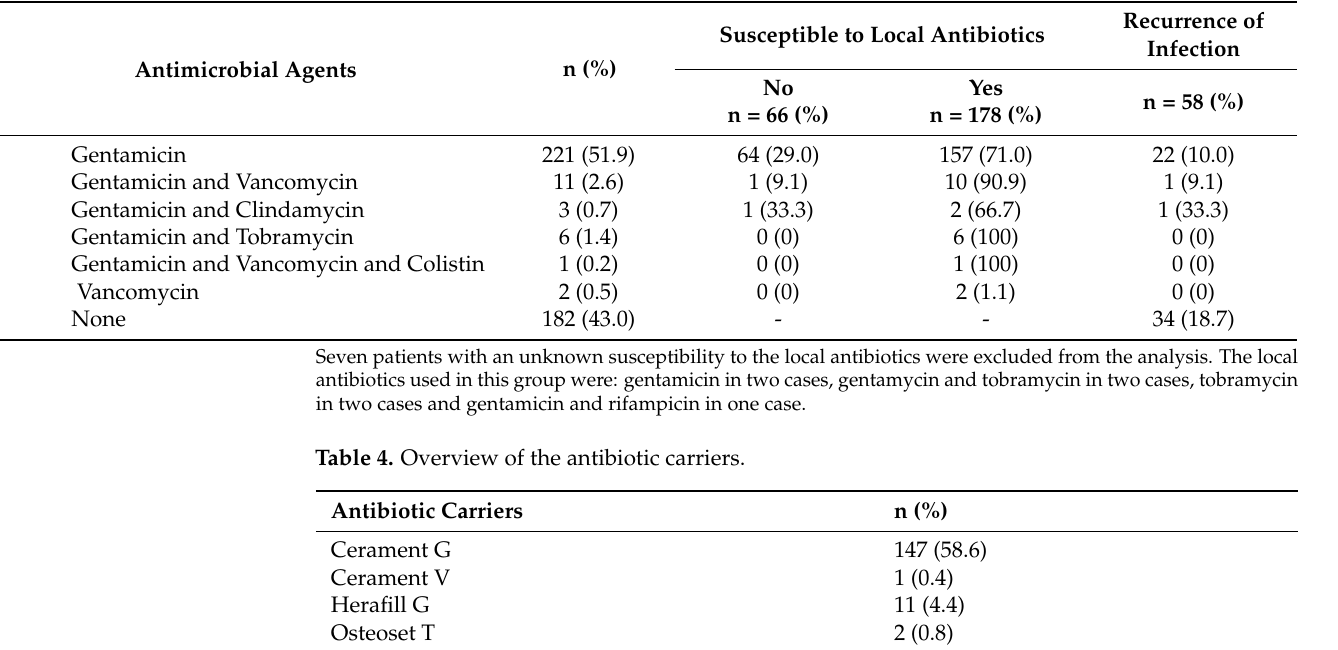
Table 3. Overview of the antibiotics used in the antibiotic-loaded carriers and the recurrence rate of infection related to the susceptibility to the implanted antibiotics.